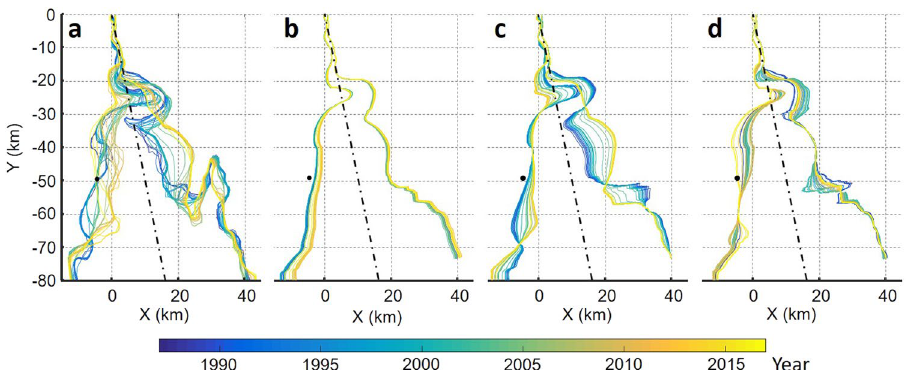
Figure 6. Empirical orthogonal function (EOF) decomposition of coastline changes from 1987 to 2017. Coastline changes deconstructed into orthogonal components. Black dash–dot lines represent estuary axis used in EOF decomposition. ( a ) Extracted coastlines for years 1987 to 2017. ( b ) First-mode EOF variance. Base coastline was created by averaging these coastlines over period. ( c ) Second-mode EOF variance on base coastline. ( d ) Third-mode EOF variance on base coastline. Second- and third-mode variances account for 81–85% of total variances excluding first-mode variance. Figure was created using MATAB version R2006b from Mathworks